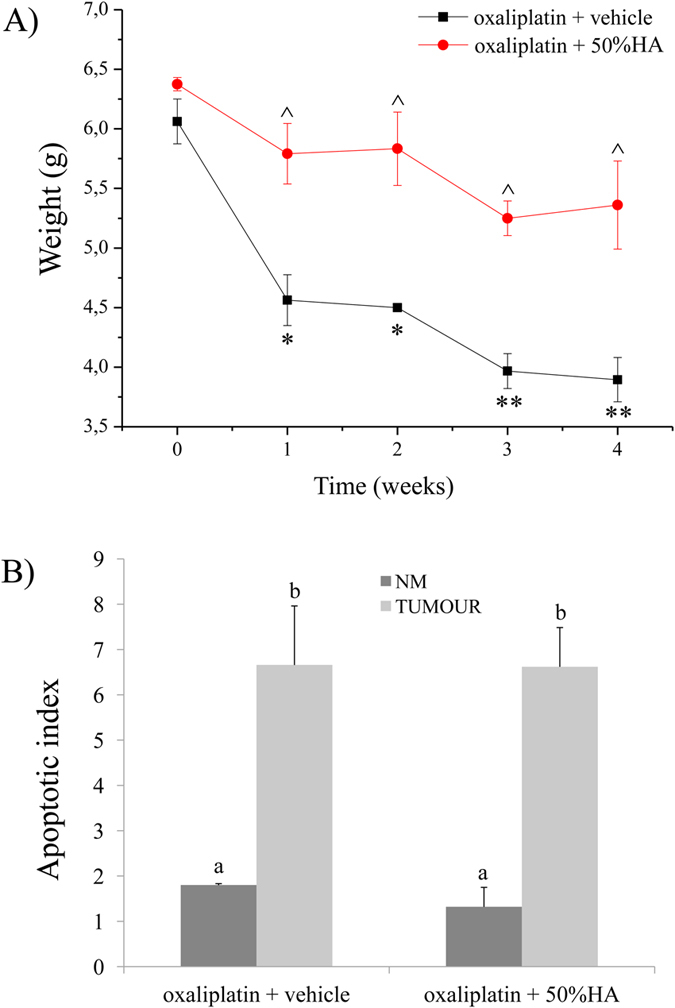
Pirc rats.(A) Pain threshold evaluation by Paw pressure test. Rats were treated with oxaliplatin 1.5 mg kg−1 i.p. twice a week for 4 weeks. 50%HA (300 mg kg−1) was administered p.o. daily for 4 weeks. Behavioural evaluations were performed 24 h after the last injection of both compounds. (B) Apoptotic index (number of apoptotic cells/cells scored x 100) in the normal mucosa (NM) and tumours from Pirc rats treated with oxaliplatin (oxaliplatin + vehicle) or oxaliplatin + 50%HA as explained in methods. Values are mean + SEM (n = 5, and 4 for NM and 9 and 13 for tumours in oxaliplatin + vehicle, and oxaliplatin + 50%HA, respectively). Bars with different superscript are significantly different (P < 0.01 with t-test).